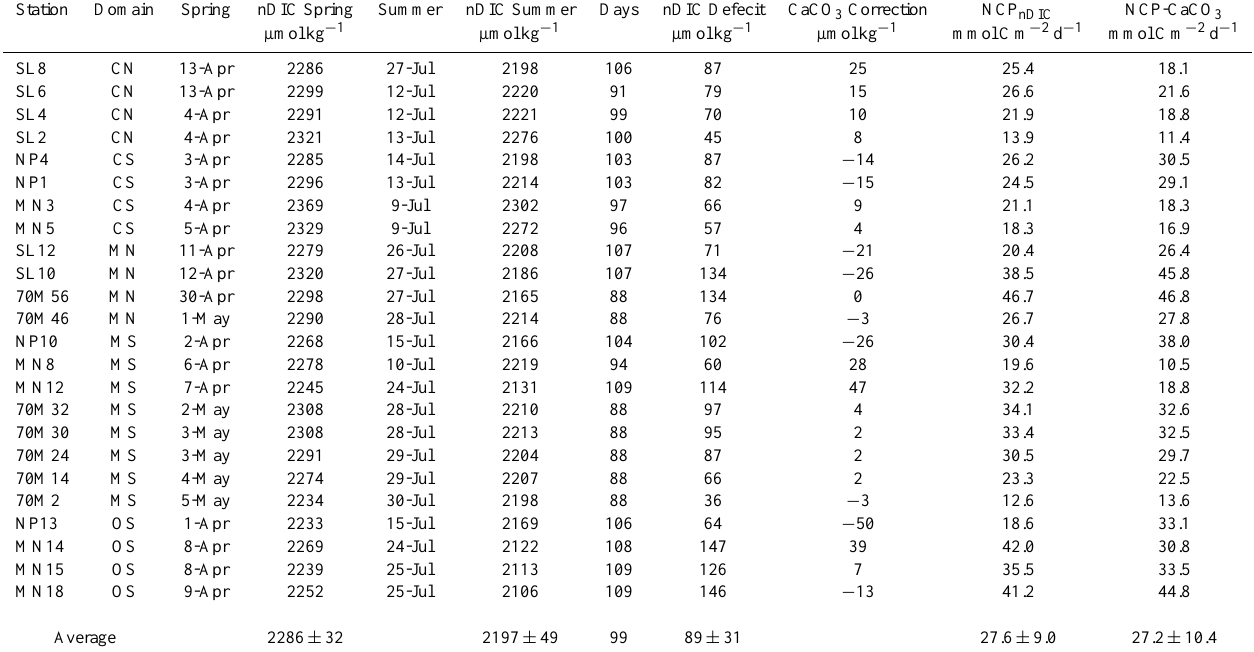
Table 3. Spring and Summer nDIC concentrations, the seasonal drawdown of normalized DIC, correction factor applied for the formation and dissolution of calcium carbonate minerals ( − 0.5* ( 1 TA + 1 NO 3 )) , rates of NCP based on the seasonal drawdown of nDIC (NCP nDIC ) , and rates of NCP based on the seasonal drawdown of nDIC and corrected for the formation and dissolution of calcium carbonate minerals (NCP nDIC − C ) by station in 2008. Drawdown of nDIC was on average ∼ 90µmoleskg − 1 , and was highest in the middle and outer domains in the region of the greenbelt, where NCP nDIC and NCP nDIC − C were also